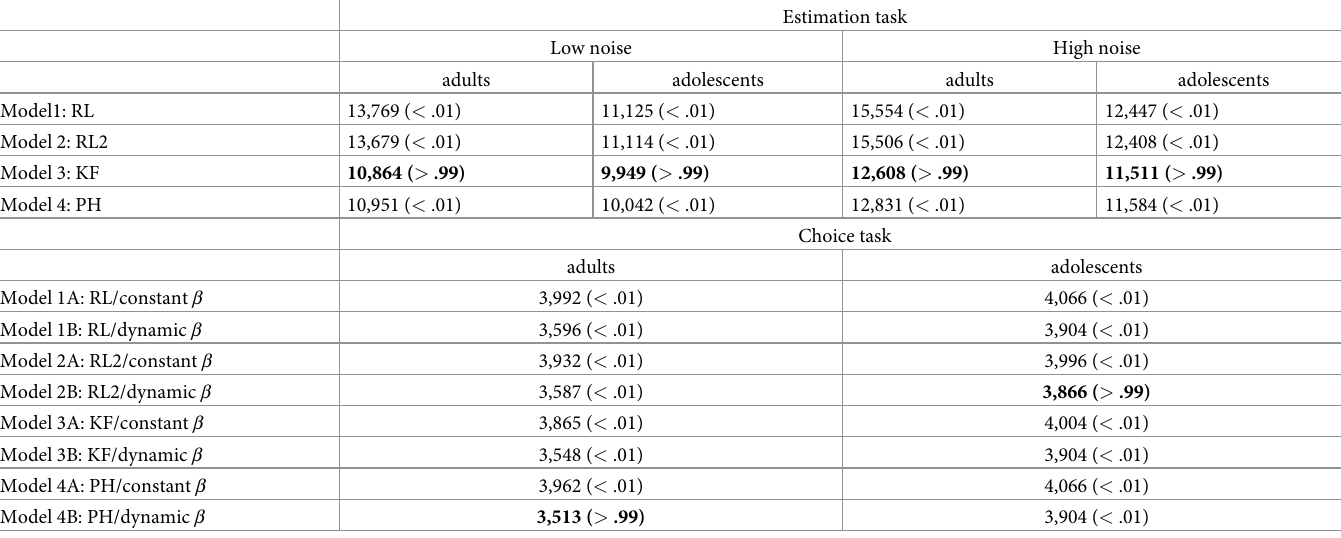
Table 1. DIC values and (in parentheses) corresponding model weights for fits of each model to each data set.